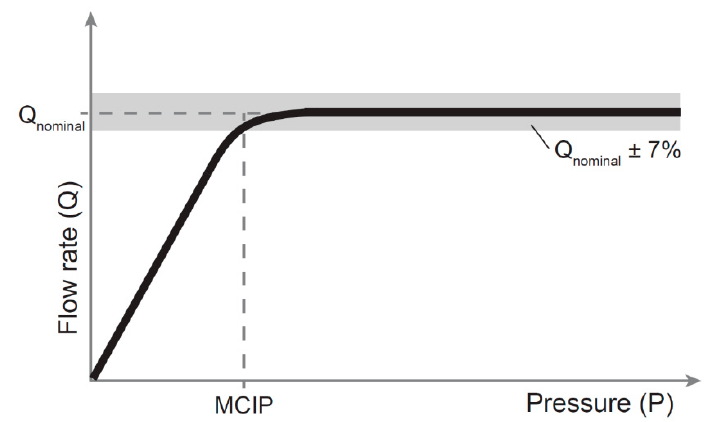
Figure 1. Relationship between flow rate and water pressure at the emitter inlet for pressure-compensating (PC) emitters. The Minimum Compensating Inlet Pressure (MCIP) is the pressure above which the emitter’s flow rate is within 7% of its nominal flow rate.